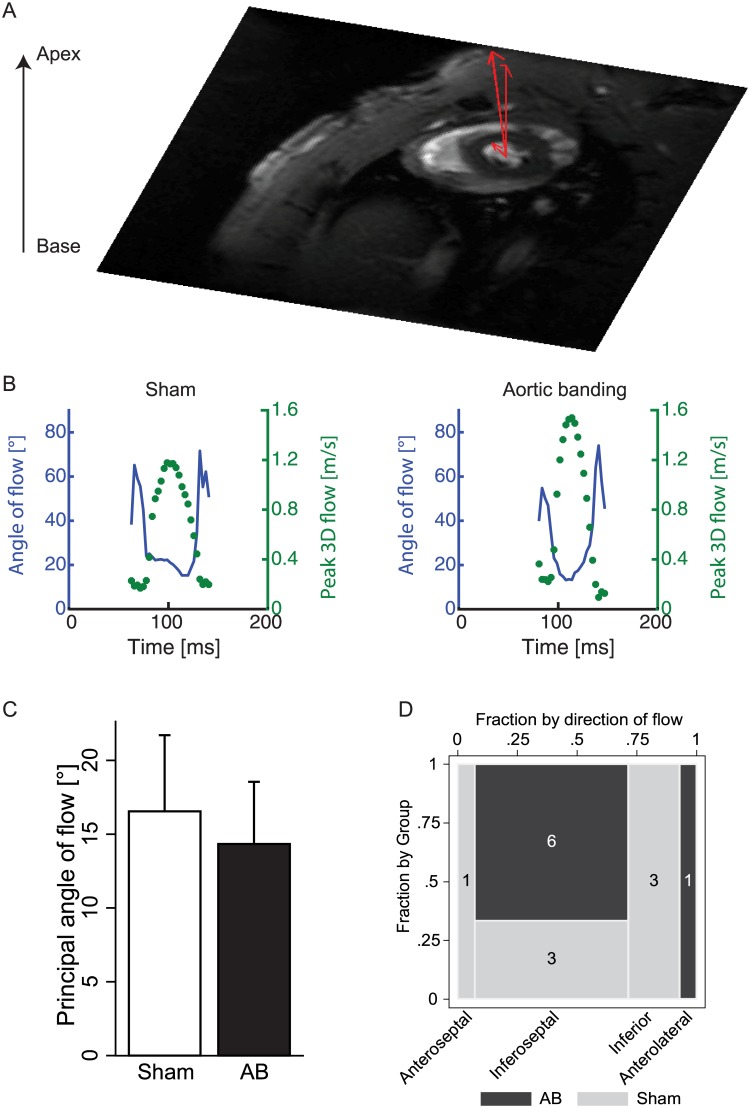
Flow distribution and direction of flow.(A) Three-directional velocity data in the mitral valve, decomposed into the through-plane and in-plane component. (B) Mitral inflow angle (solid, blue line) overlaid with the peak mitral flow profile (dashed, green) during the duration of diastole in a sham and banded animal. (C) The principal angle of flow between the three-directional velocity vector and the through-plane component in sham and the aortic banding (AB) rats. (D) Mosaic plot of the in-plane direction of flow in sham and AB rats describing inferoseptal and/or inferior direction of flow in 12 out of 14 animals. The number in each box indicates the number of animals that display this particular direction of mitral flow. Values are presented as mean ± standard deviation.